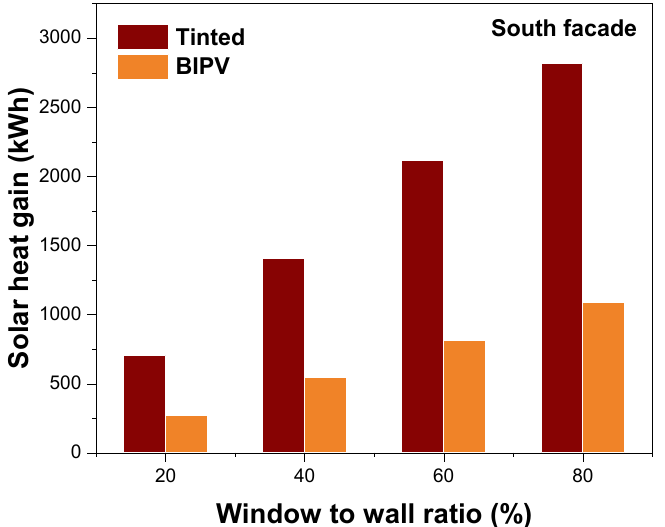
Figure 14. Solar-heat gain for the south façade.